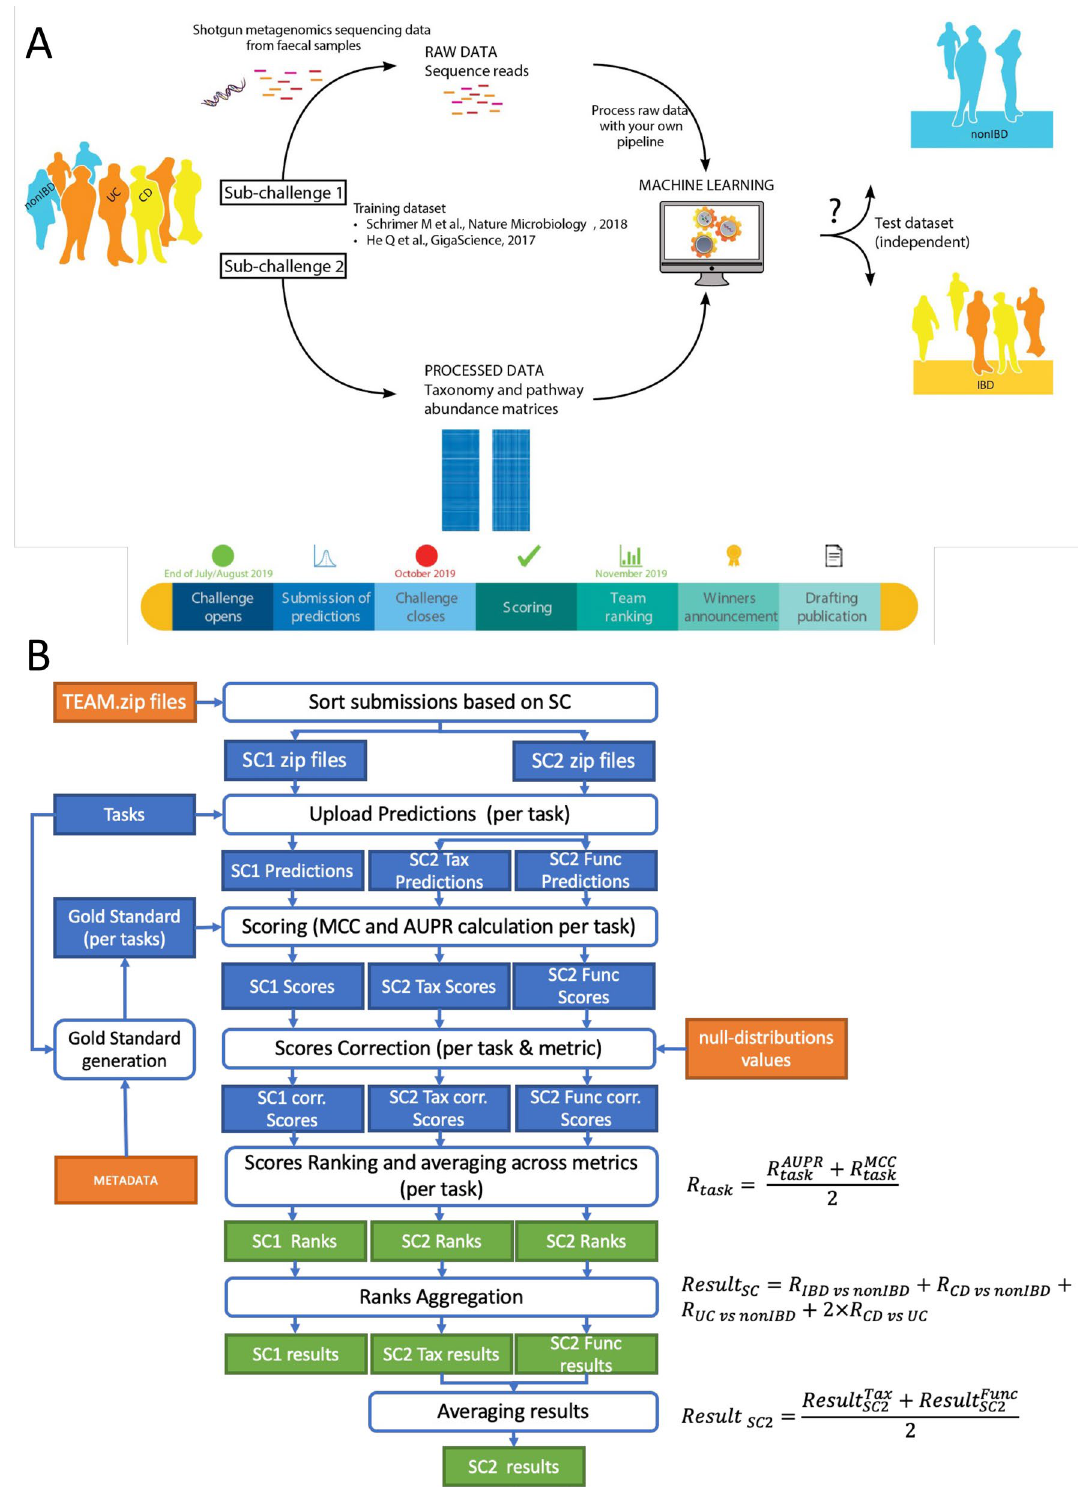
Figure 1. Overview of the metagenomics for IBD diagnosis challenge. ( A ) challenge design, ( B ) challenge scoring